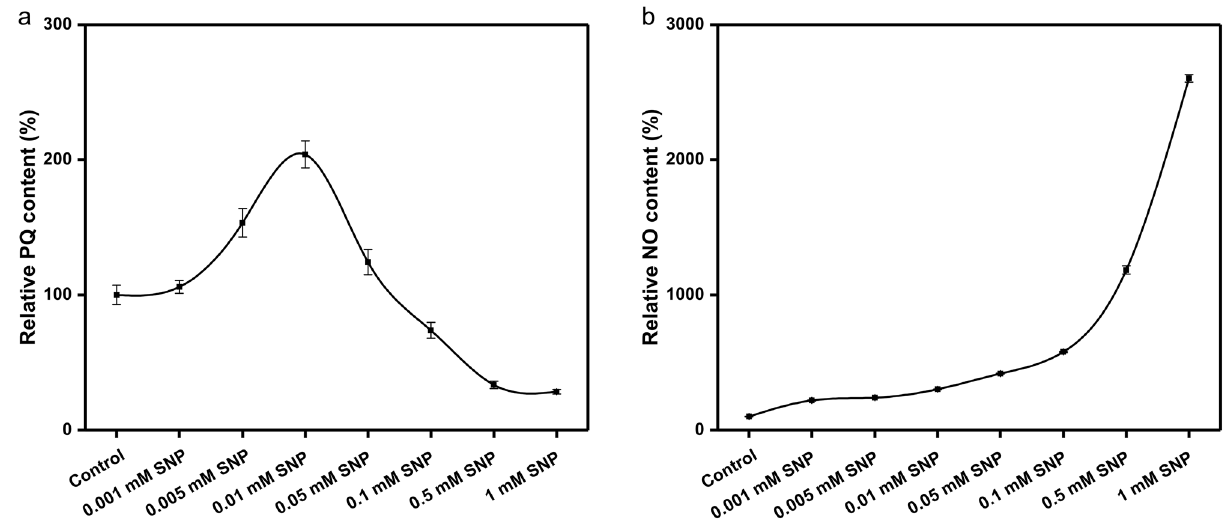
Figure 3. Effects of different concentrations of SNP on perylenequinones production and intracellular NO. Values are the means of five independent experiments ±